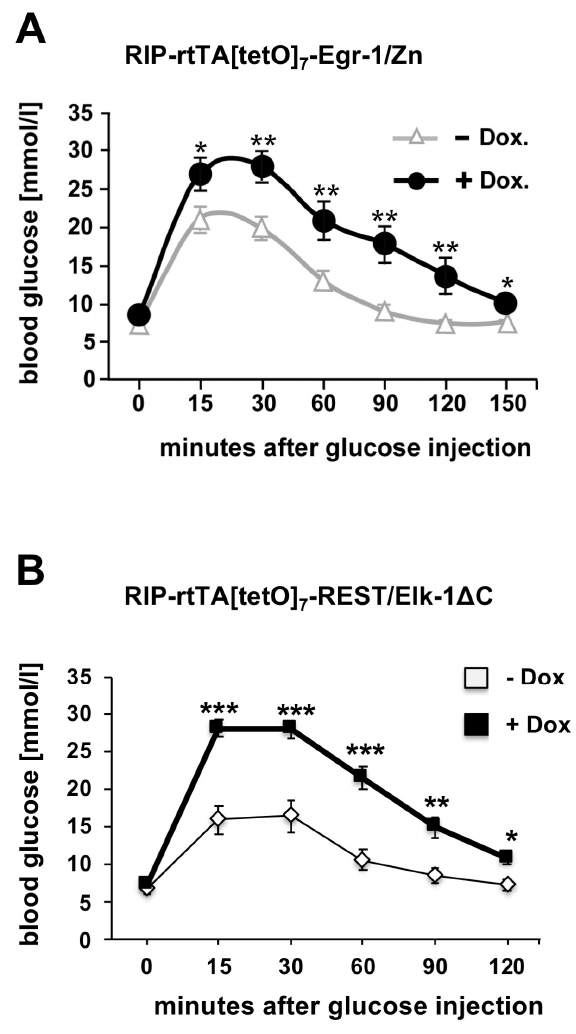
Figure 6. Glucose intolerance in transgenic mice expressing Egr-1/Zn or REST/Elk-1 Δ C in pancreatic β -cells. Double transgenic RIP-rtTA/[tetO] 7 /Egr-1/Zn ( A ) or RIP-rtTA/[tetO] 7 REST/Elk-1 Δ C mice ( B ) were used for glucose tolerance tests. Animals received doxycycline in the drinking water (+DOX) or not ( − DOX). Statistics: +/ − SEM, *, p < 0.05; **, p < 0.01; ***, p < 0.001; n = 3). Reproduced with